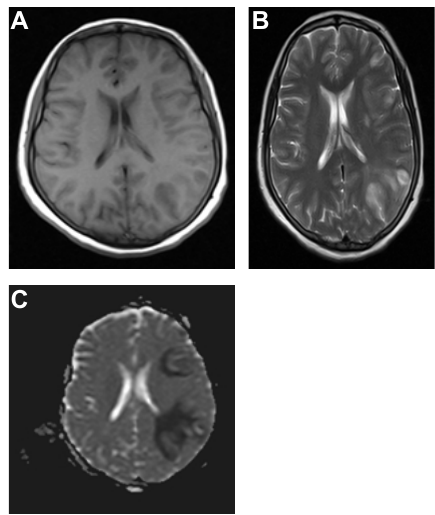
Figure 1. (A) Brain MRI T1. (B) Brain MRI T2. (C) Brain MRI